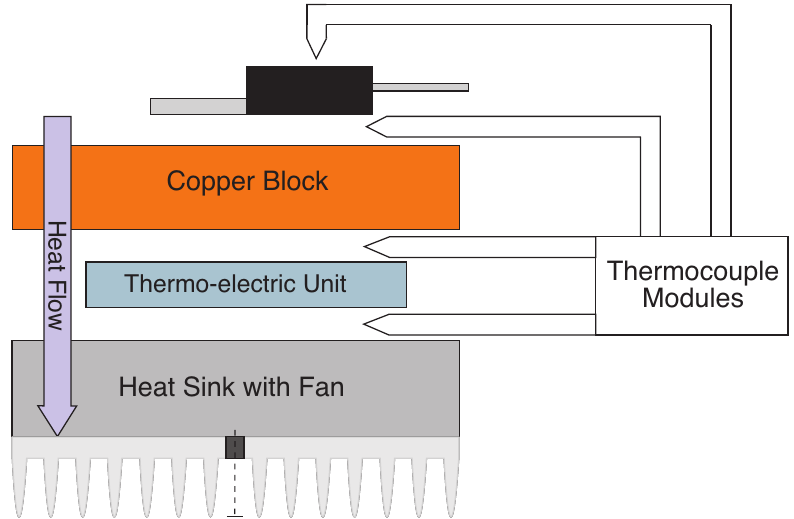
Figure 6. Thermal block and its application for MOSFETs’ accelerated